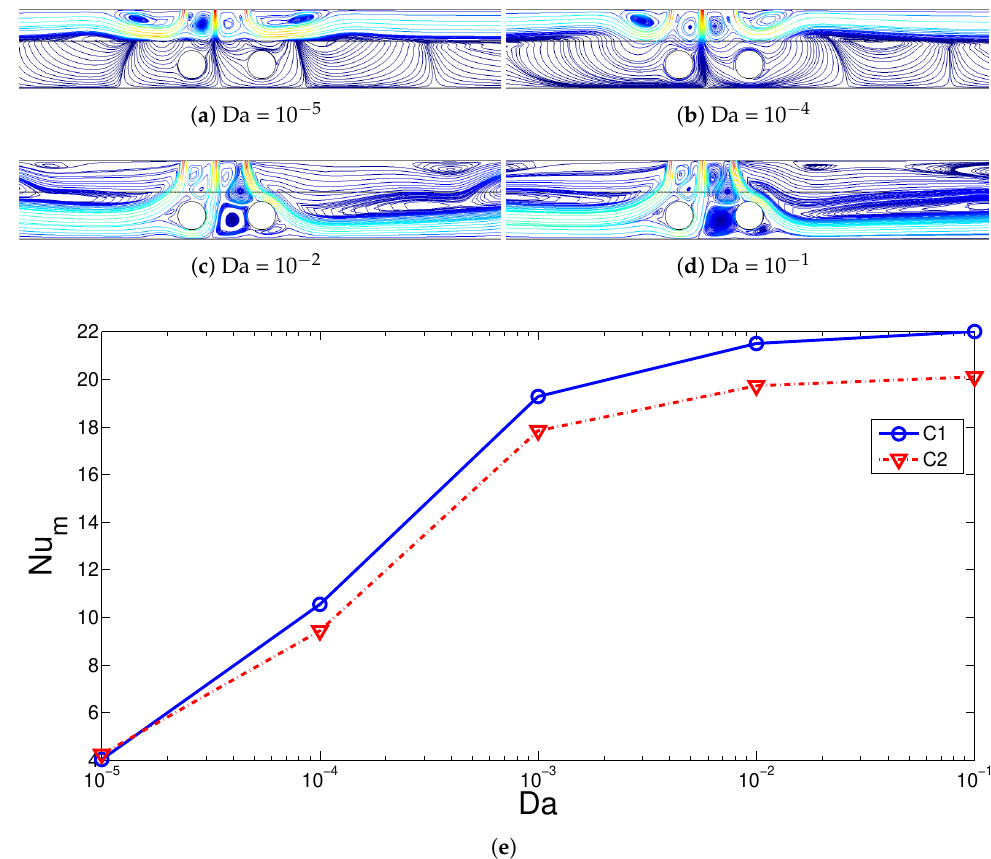
Figure 7. Effects of permeability of the embedded region on the streamline variations ( a – d ) and average Nu variations for hot cylinders C1 and C2 ( e ) (Re = 300, Rew = − 300, sc = 3Rc, HNF-2%).